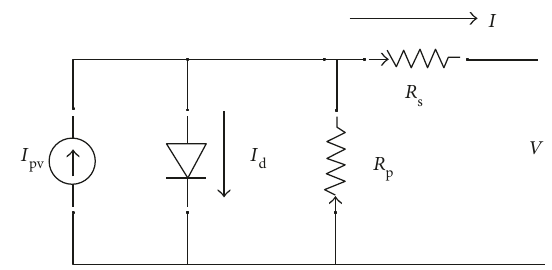
Figure 1: Single-diode equivalent circuit of a practical PV